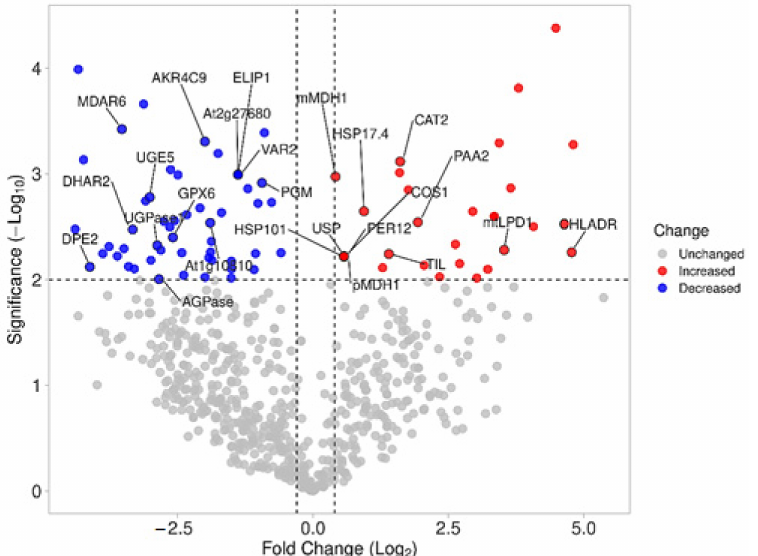
Figure 2. The volcano plot representation of total identified proteins in OTC and OUT samples. In red and blue are reported the statistically significant ( p -value < 0.01) up- (log 2 FC > 0.4) and downregulated (log 2 FC < − 0.5) proteins, respectively. In gray are reported the non-significant proteins ( p -value ≥ 0.01 and/or − 0.5 ≤ log 2 FC ≤ 0.4). The gene names of A. thaliana orthologs are reported for the representative proteins of the pathways